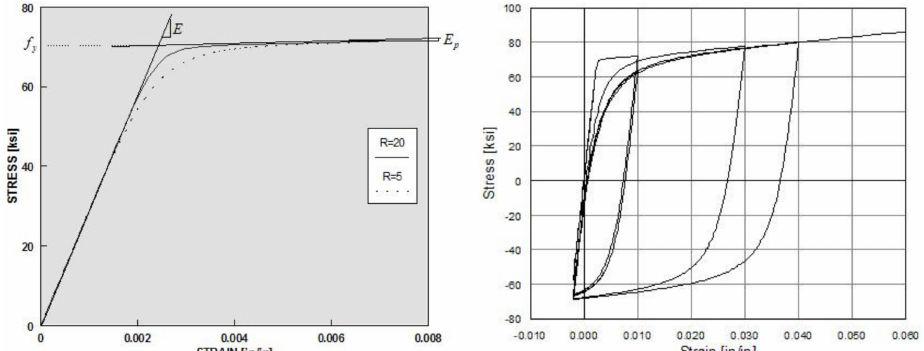
Figure 2. Material parameters for the Concrete 01 model [23].